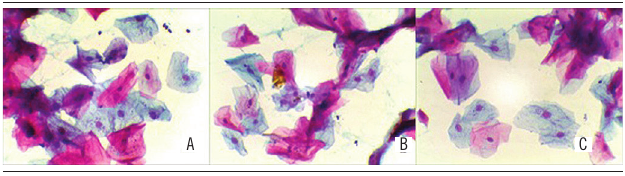
FigurE 3 − Staining classified as good in three fixation times A) seven days fixation; B) 30-minutes fixation; C) 15-minutes